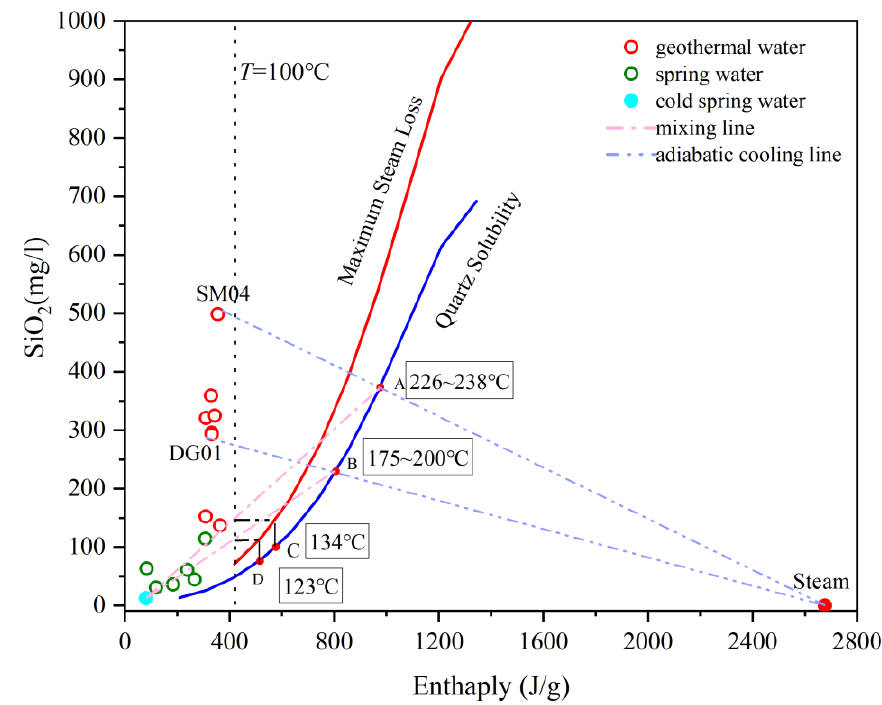
Figure 6. Silica-enthalpy mixing models of water samples along the TNR.